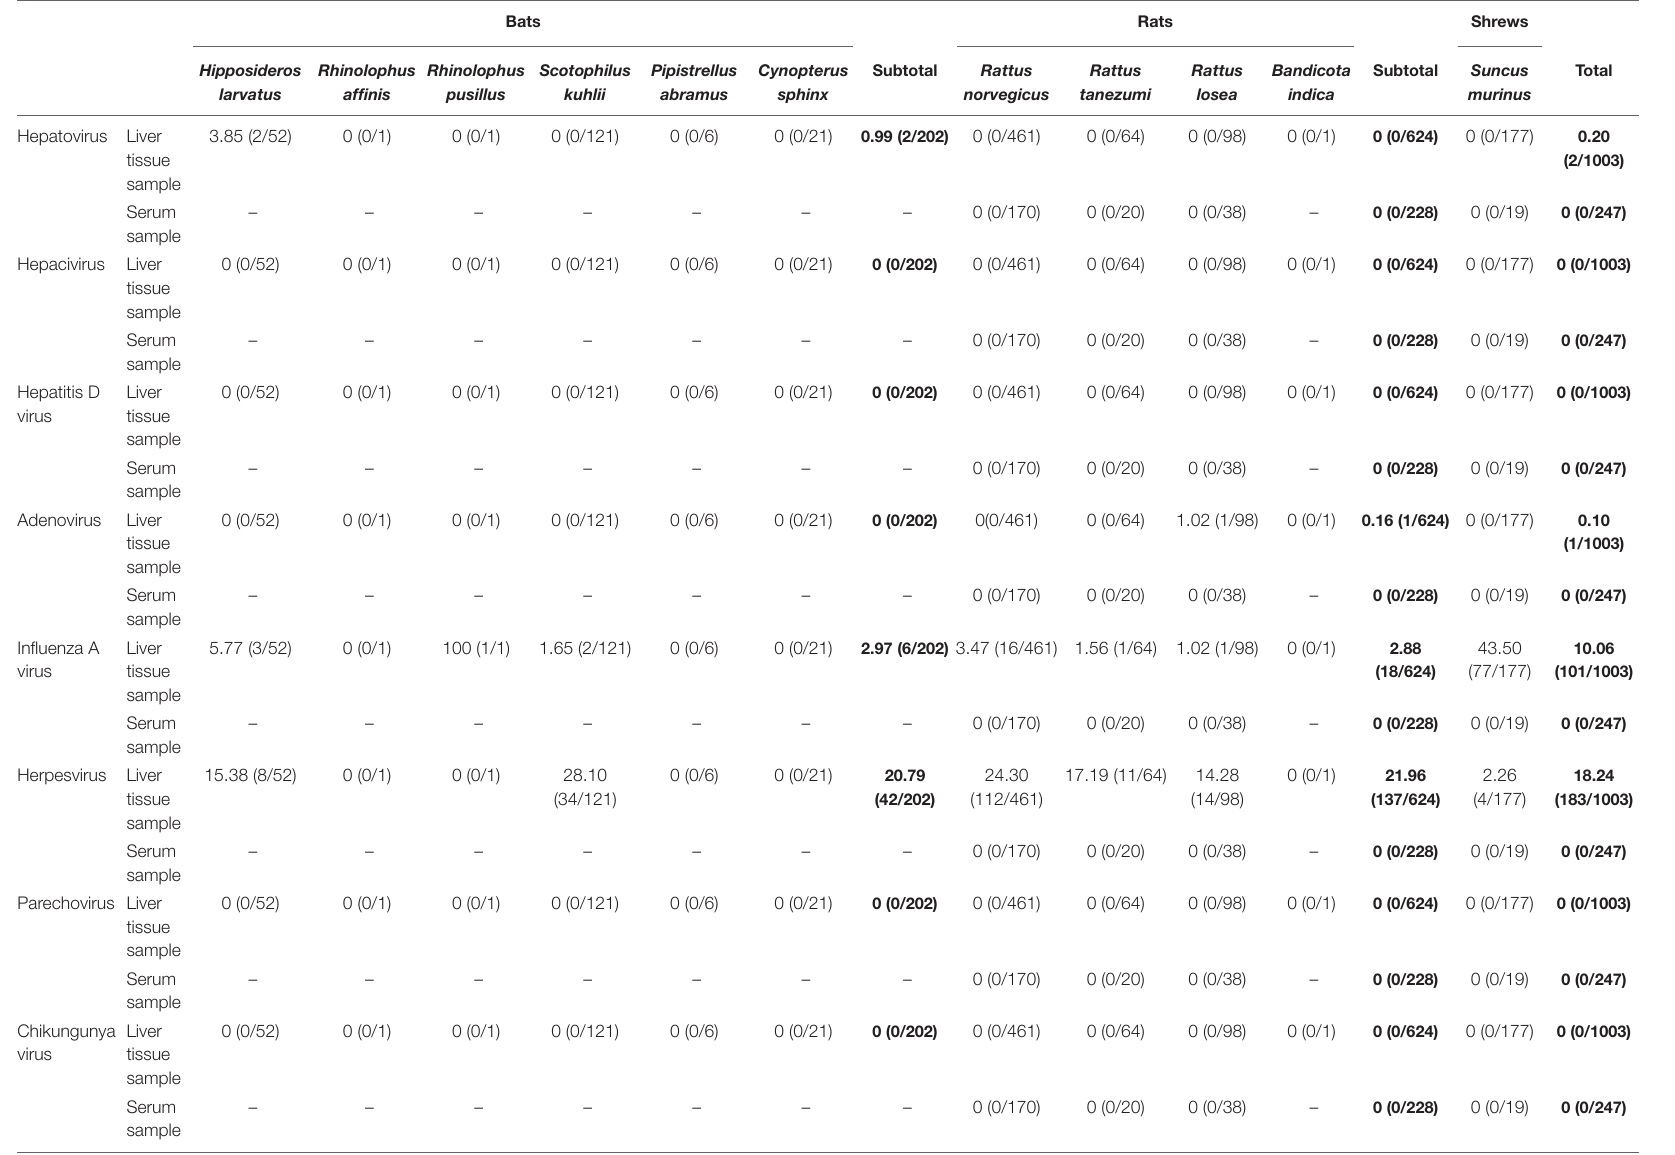
TABLE 2 | Detection of the viral sequences in